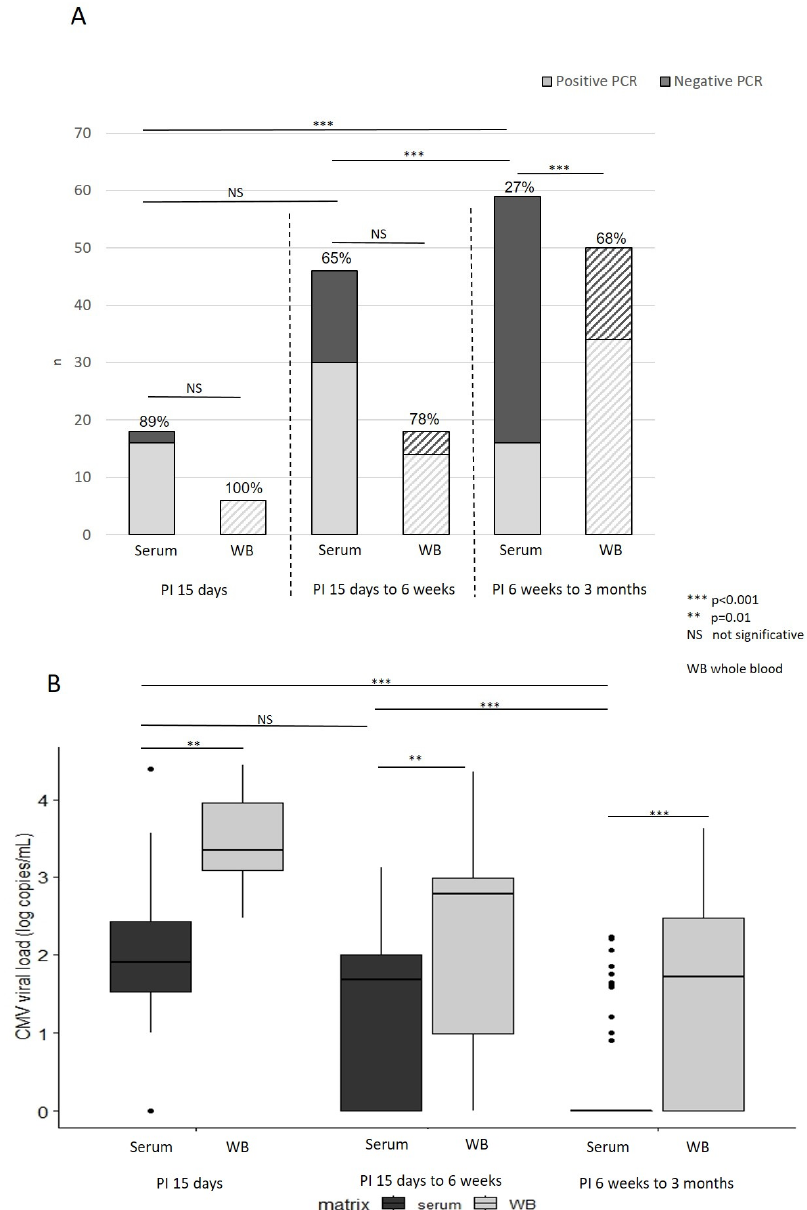
Figure 1. Qualitative and quantitative performances of CMV PCR in serum and whole blood in pregnant women with recent PI. ( A ) Sensitivity of CMV PCR in serum and in whole blood according to the delay after primary infection (PI) in pregnant women. Barplot representing percentage of serum or whole blood samples with positive CMV PCR (sensitivity) depending on the time lapse since the onset of PI: Light grey bars represent negative CMV PCR and dark grey bars represent positive CMV PCR. Serum samples are colored and whole blood samples are represented with hatched lines. Chi-squared test results are given so as to compare PCR sensitivity according to the matrix (serum versus whole blood) and according to the time lapse since PI. ( B ) Quantitative CMV PCR results in serum and in whole blood according to the time interval since (PI) in pregnant women. Boxplot representing CMV viral loads in serum and whole blood depending on the delay time since the onset of PI: Grey plots represent serum samples and yellow plots represent whole blood samples. Wilcoxon test results are given so as to compare CMV viral loads according to the matrix (serum versus whole blood) and according to the time lapse since PI. PI: primary infection. ***: p < 0.001; **: p = 0.01; NS: not